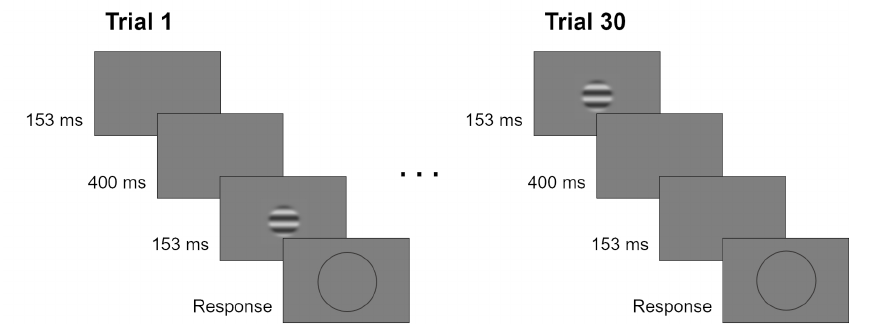
Figure 3. Two-interval forced-choice sequence for one achromatic test block. This sequence was repeated for eight randomized blocks in total: the achromatic block and three chromatic blocks for spatial frequencies of 3 and